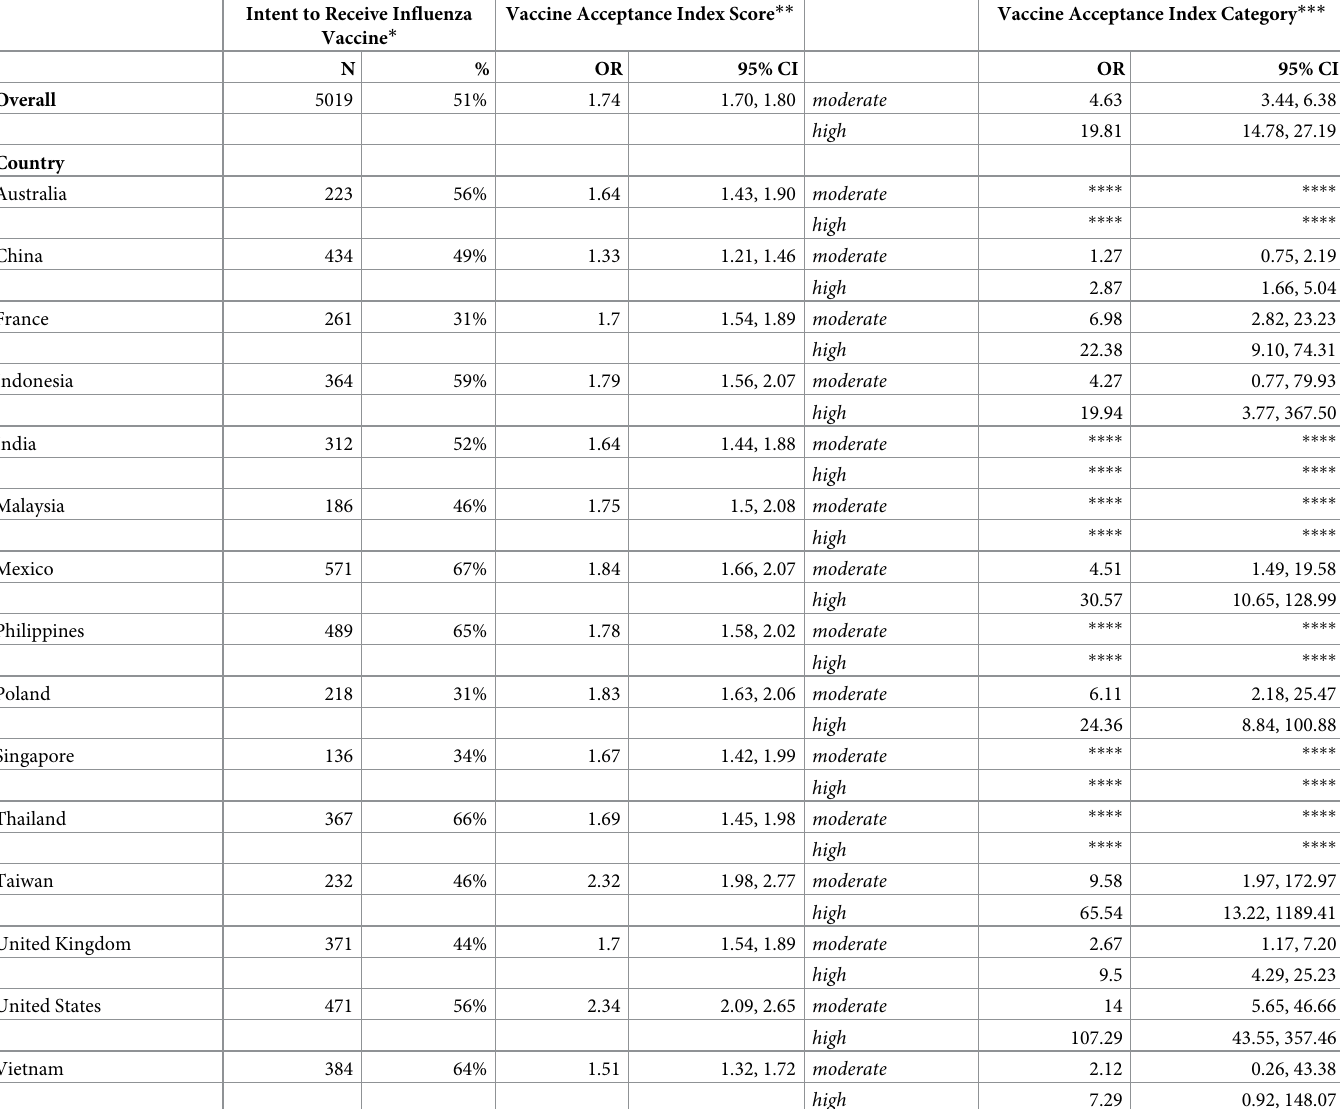
Table 4. Unadjusted associations between Vaccine Acceptance Index score and intent to receive the influenza vaccine in the next influenza season *